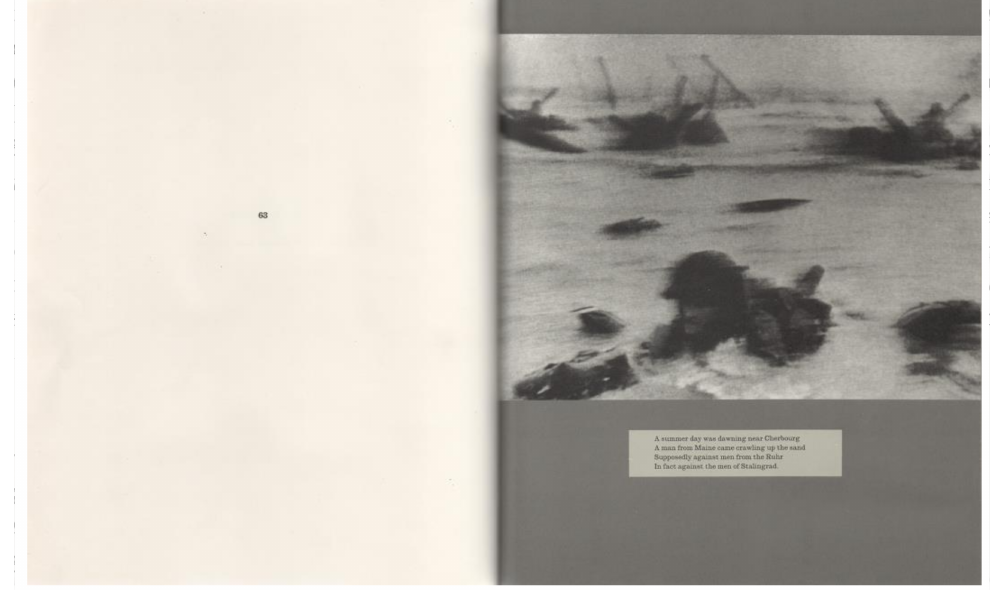
Figure 4. Bertolt Brecht. 1998. War Primer . London: Libris. Plate 63.